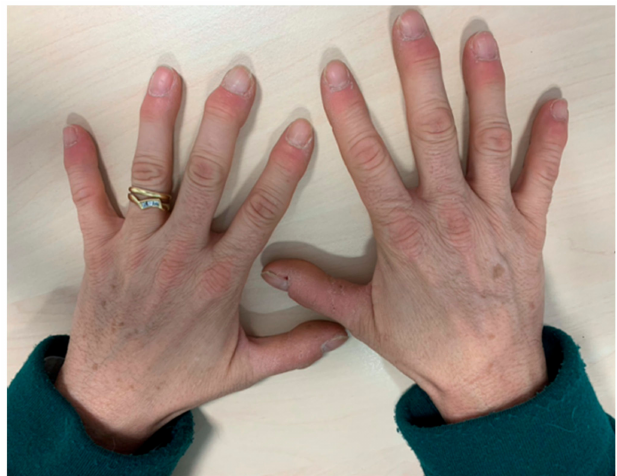
Figure 3. Symmetric distal swelling of interphalangeal joints with painful erythema in periarticular